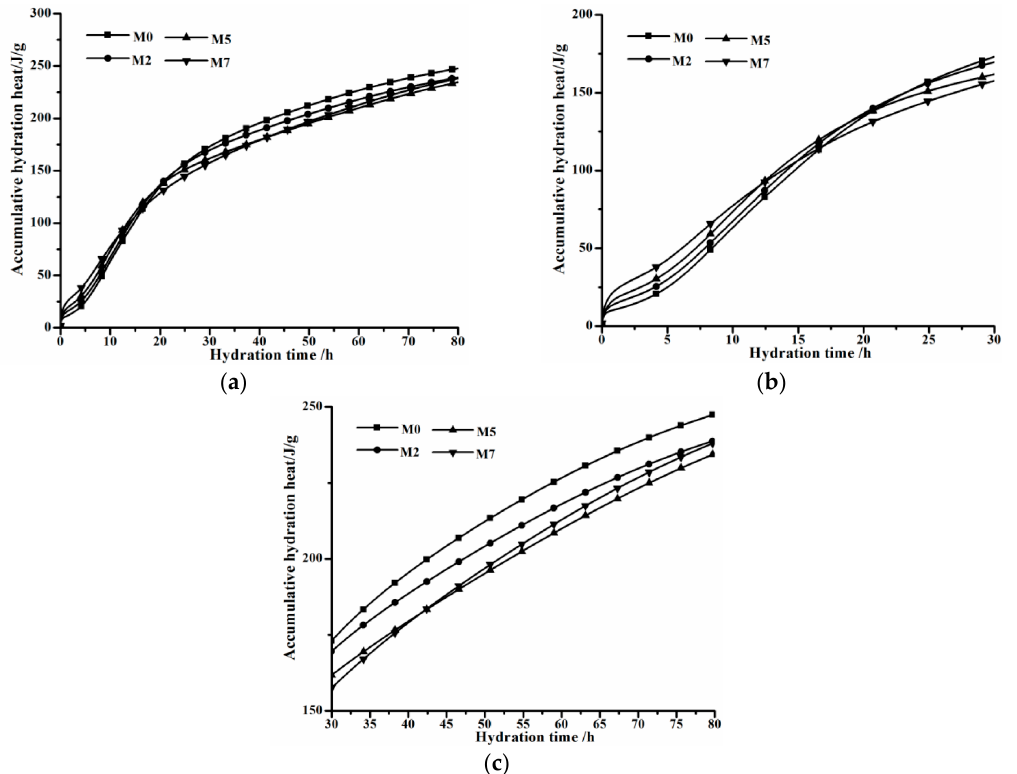
Figure 5. Accumulative hydration heat curves of groups with various C 12 A 7 replacements. ( a ): in the 0–80 h range; ( b ) in the 0–30 h range; ( c ) in the 30–80 h range.